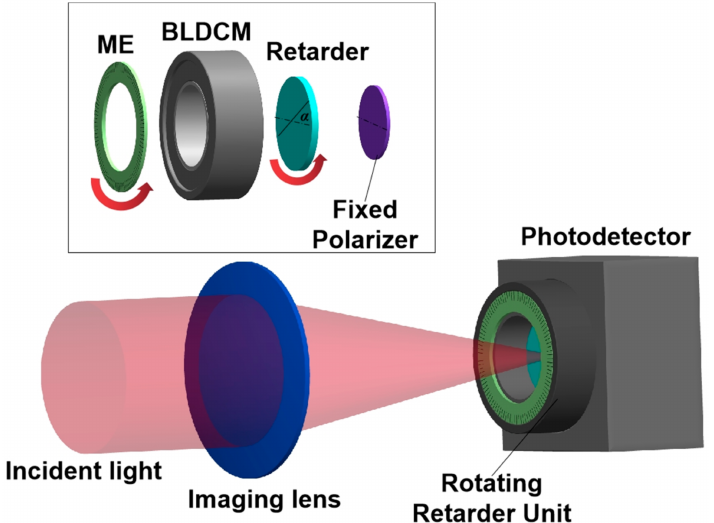
Figure 1. Schematic layout of full-Stokes imaging polarimeter by time integration ( α : azimuthal angle of the rotating